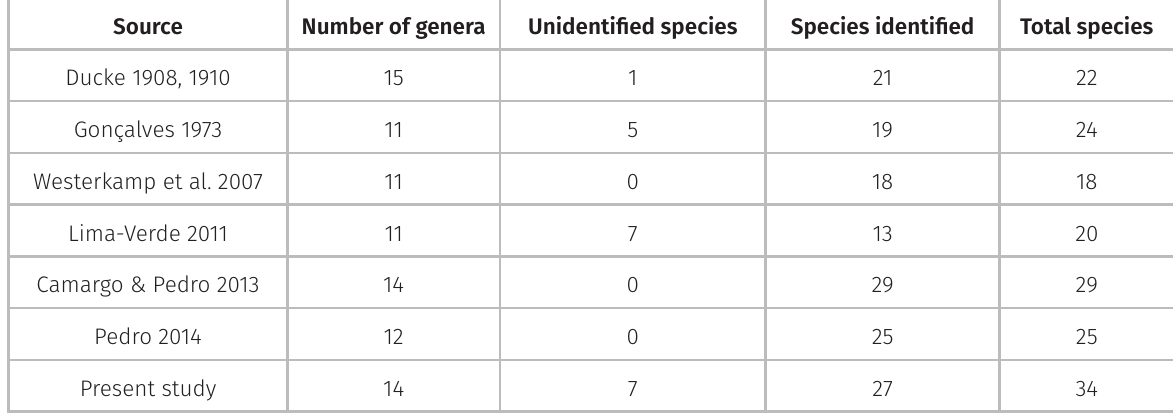
Table III. Number of genera and species cited in the main studies and in the present study on the occurrence of meliponines for the State of